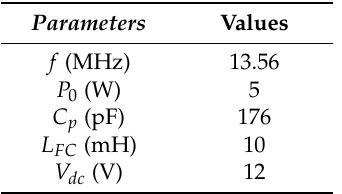
Table 2. Class E amplifier